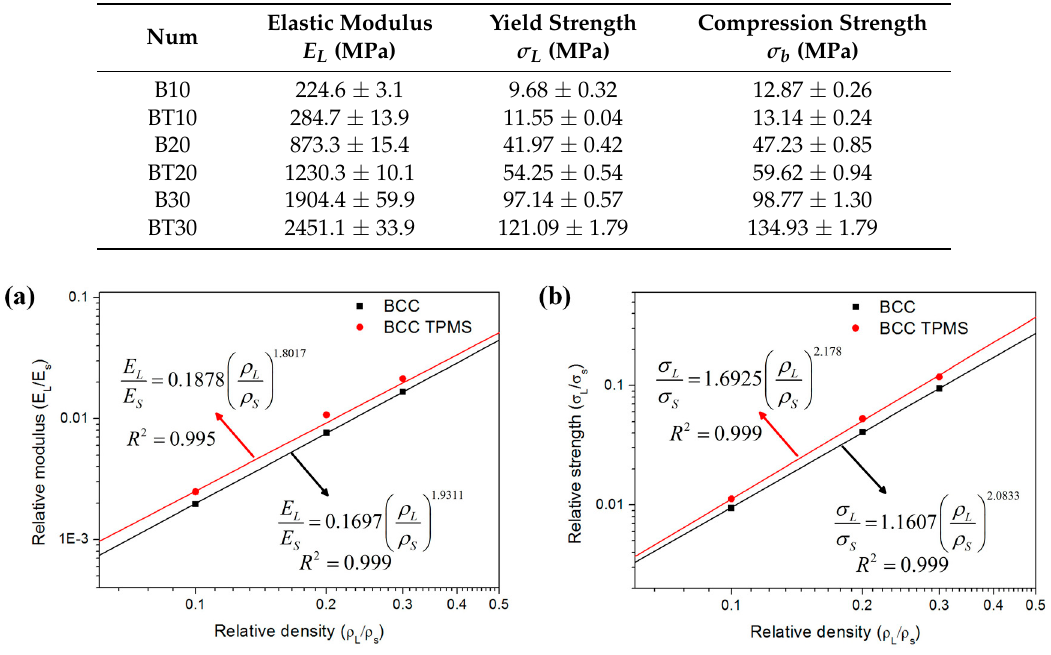
Figure 11. Variation of ( a ) the relative modulus and ( b ) the relative strength of the CAD-based and TPMS-based BCC lattice structures with relative density (three replicate specimens, means and standard deviations).